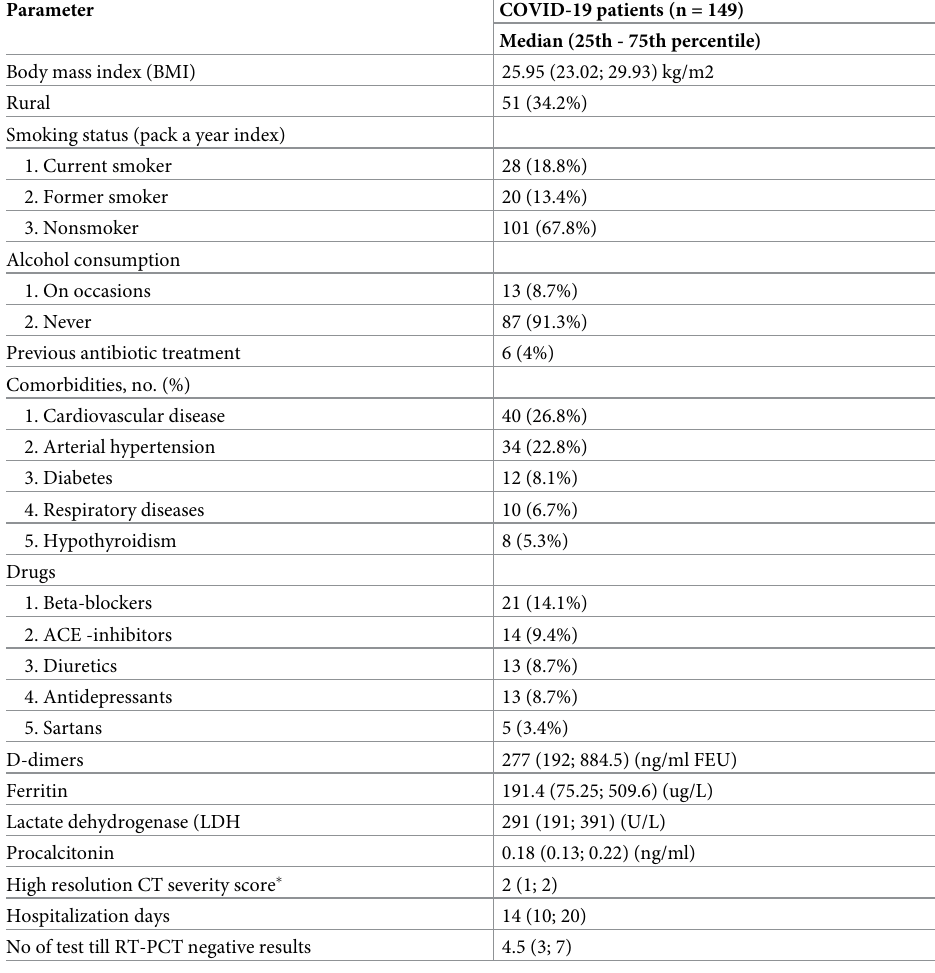
Table 1. Demographics and clinical characteristics of COVID-19